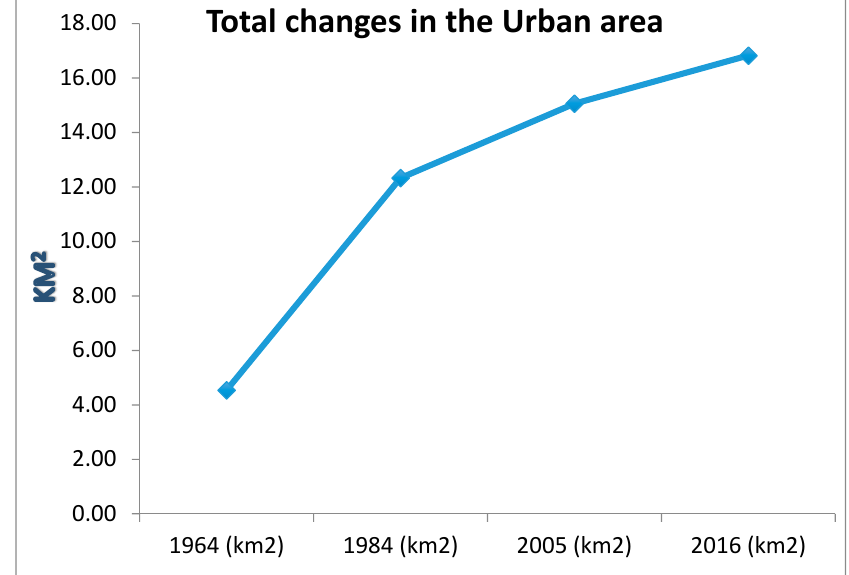
Figure 13. Total changes in the urban area by the graph.